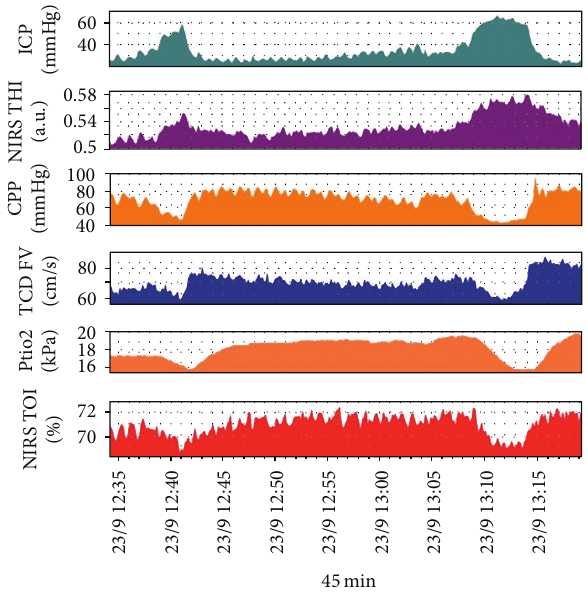
Figure 8: Multimodal monitoring during a plateau wave of ICP, demonstrating a decrease in CPP, PbtO 2 , blood flow velocity (which was assessed with TCD), and HbO 2 during the curve, resulting in an ischaemic insult. ICP: intracranial pressure. NIRS THI: near infrared spectroscopy, tissue haemoglobin index. CPP: cerebral perfusion pressure. TCD FV: Trans Cranial Doppler Flow Velocity. PtiO2: brain tissue oxygenation. NIRS TOI: near infrared spectroscopy, tissue oxygenation